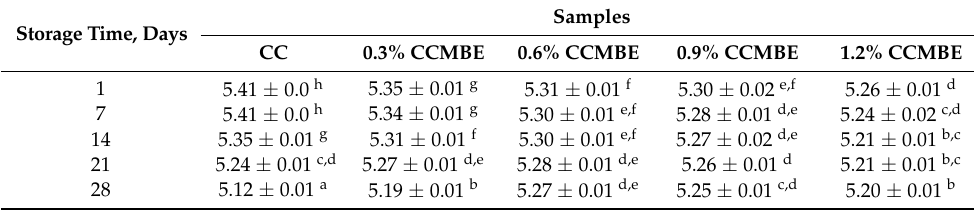
Table 5. pH value evolution of cream cheese fortified with microencapsulated basil extract, dur- ing